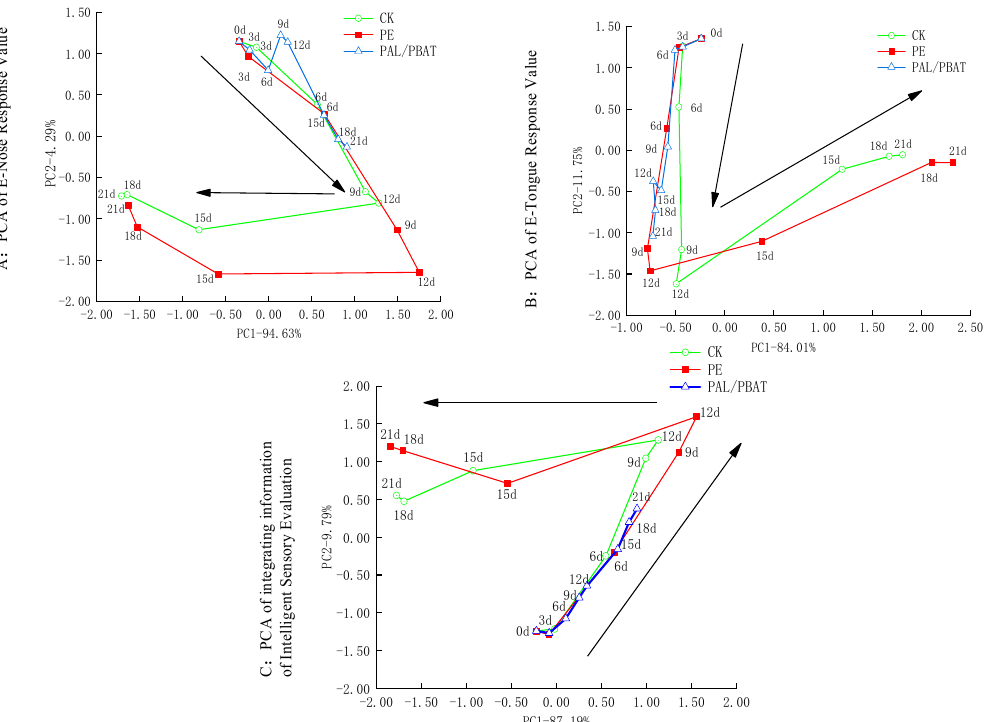
Figure 3. E ff ect of PLA / PBAT antibacterial packaging film on the ( a ) e-nose response signal, ( b ) e-tongue response signal, ( c ) fusion information of e-nose and e-tongue response of passion fruit during storage times (t = 8), based on principal component analysis (PCA). Note: All black arrows indicate the direction of displacement in PC1.